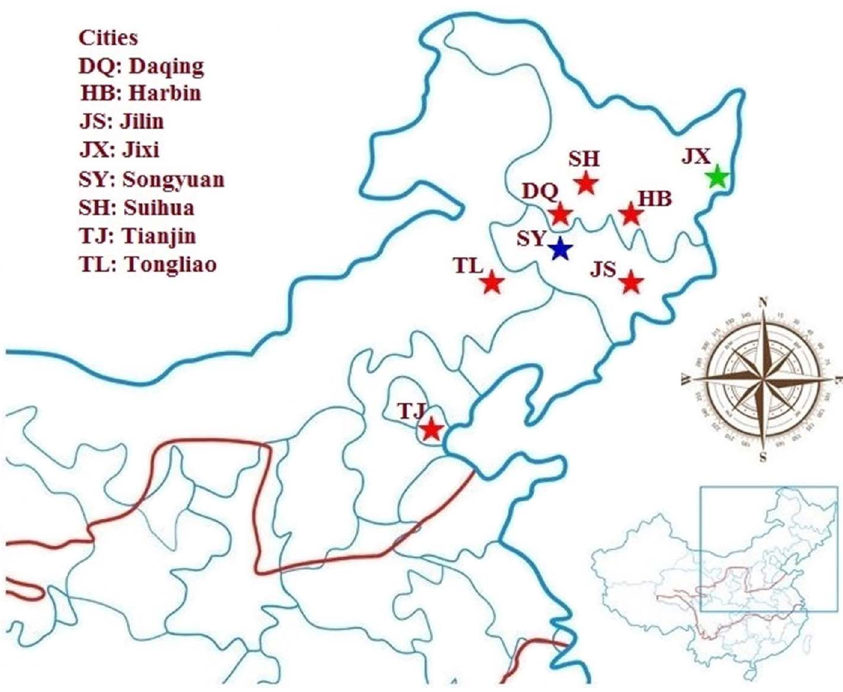
Figure 1. Existence of Enterocytozoonbieneusi in multiple cities in China. Red stars: cities (Daqing, Jilin, Harbin, Suihua, Tianjin, and Tongliao) where infections of E. bieneusi in pigs were examined; green star: city Jixi where infections of the pathogen in chickens were examined; blue star: city Songyuan where the organism was identified in both chicken and pigs.